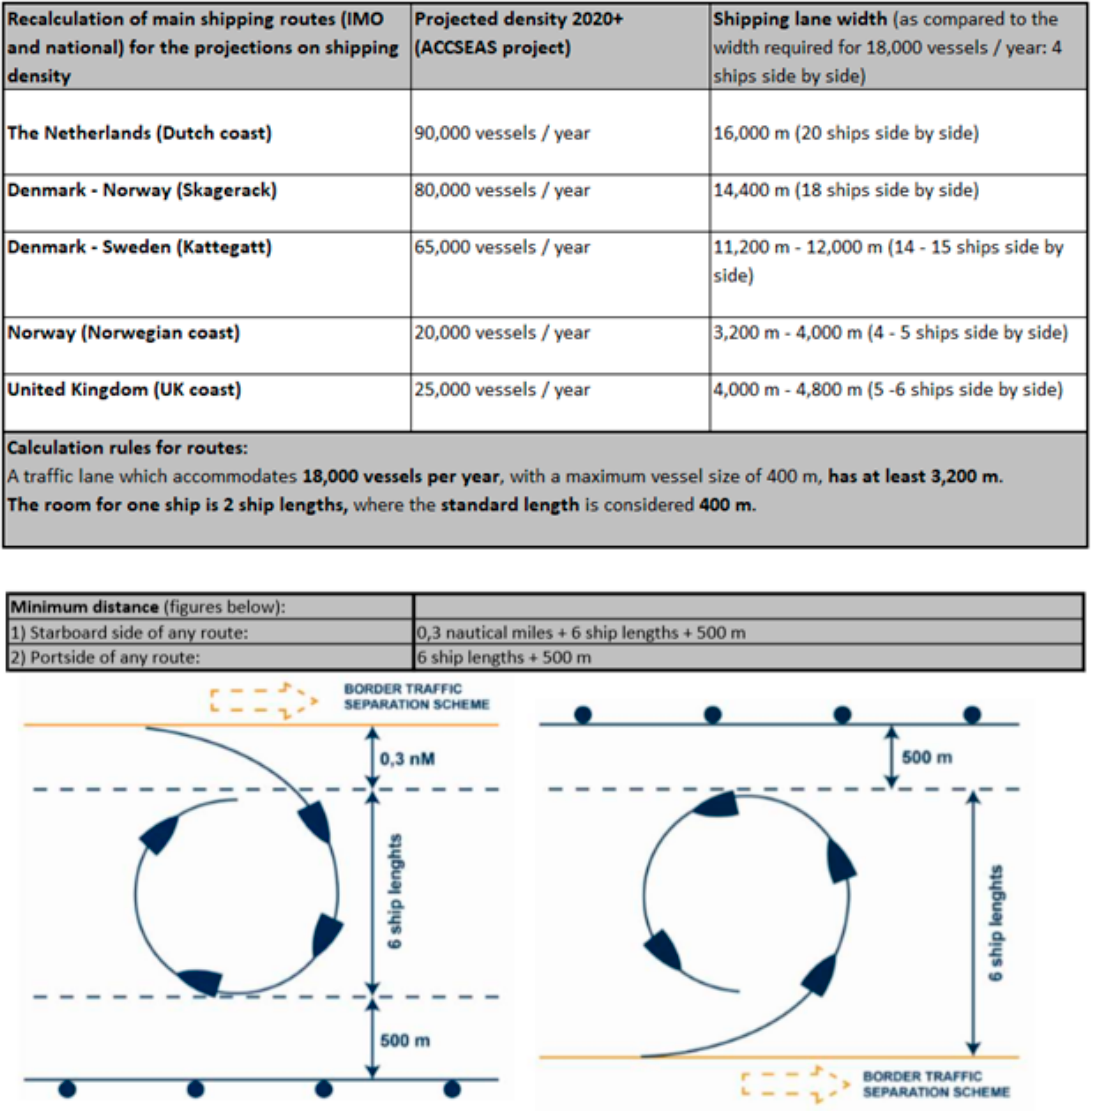
Figure A2. Calculation rules for future shipping lanes (using projections from ACCSEAS—Accessibility for shipping. Efficiency, Advantages and Sustainability project: http://www.accseas.eu/) . Source of calculation of shipping lane width rules: Confederation of European Shipmasters’ Associations, International regulations and guidelines for maritime spatial planning related to safe distances to multiple o ff shore structures (e.g., wind farms). Table A3. Coding of the interviews .